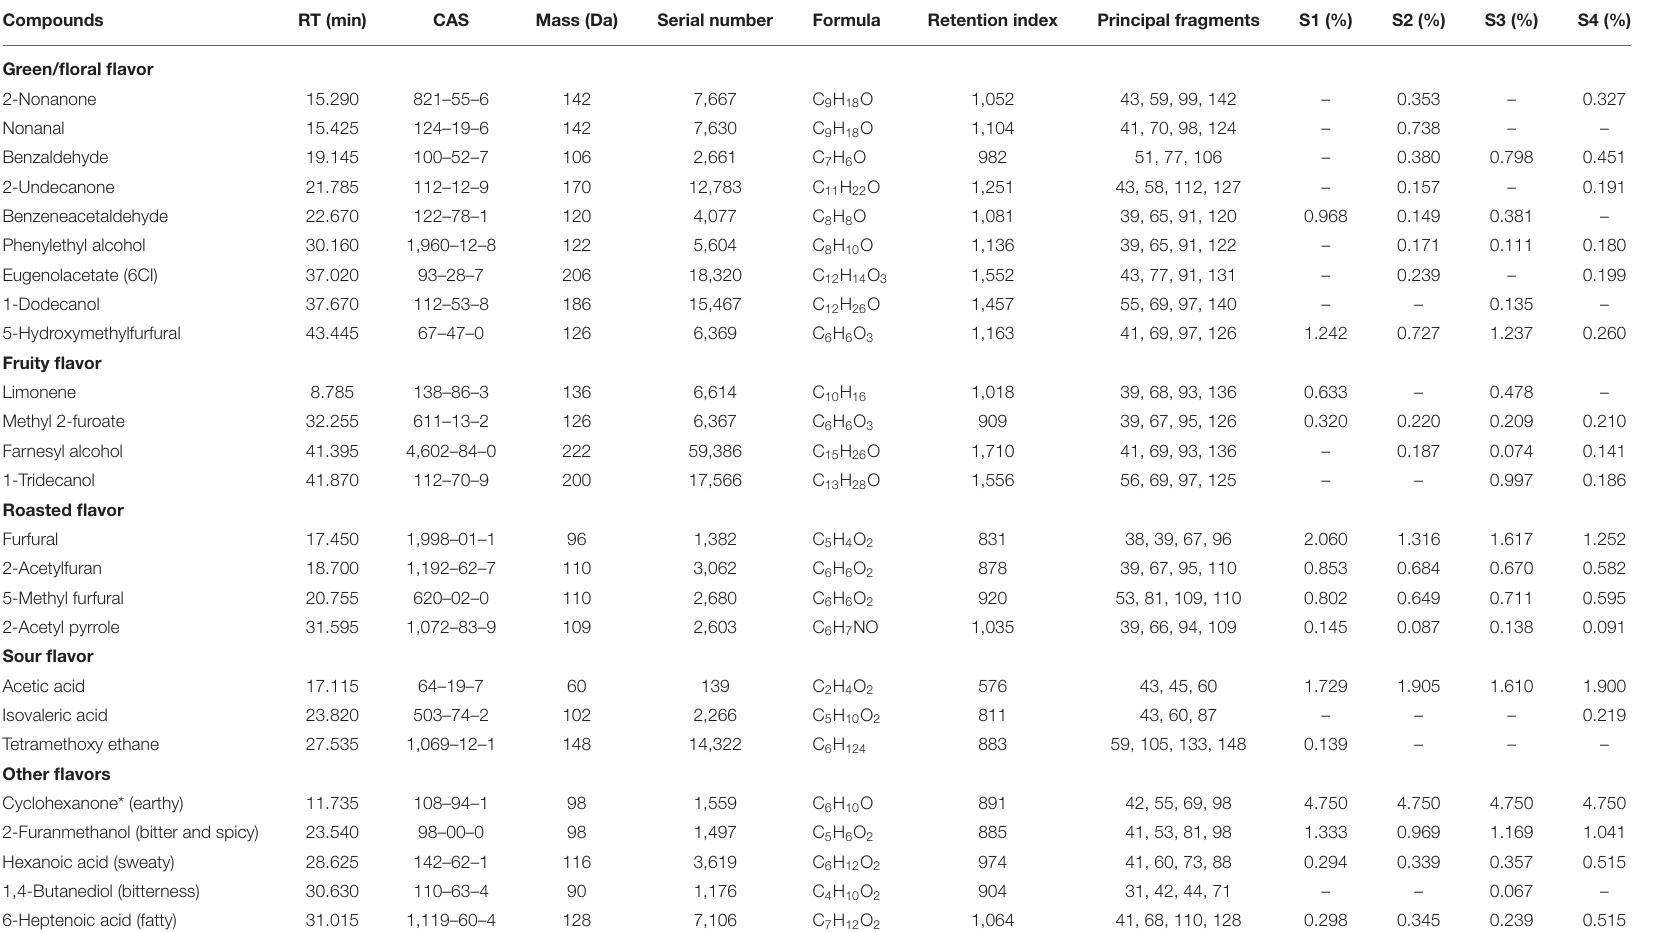
TABLE 2 | HS-SPME–GC-MS identification of the main functional volatile substances in black garlic broth.